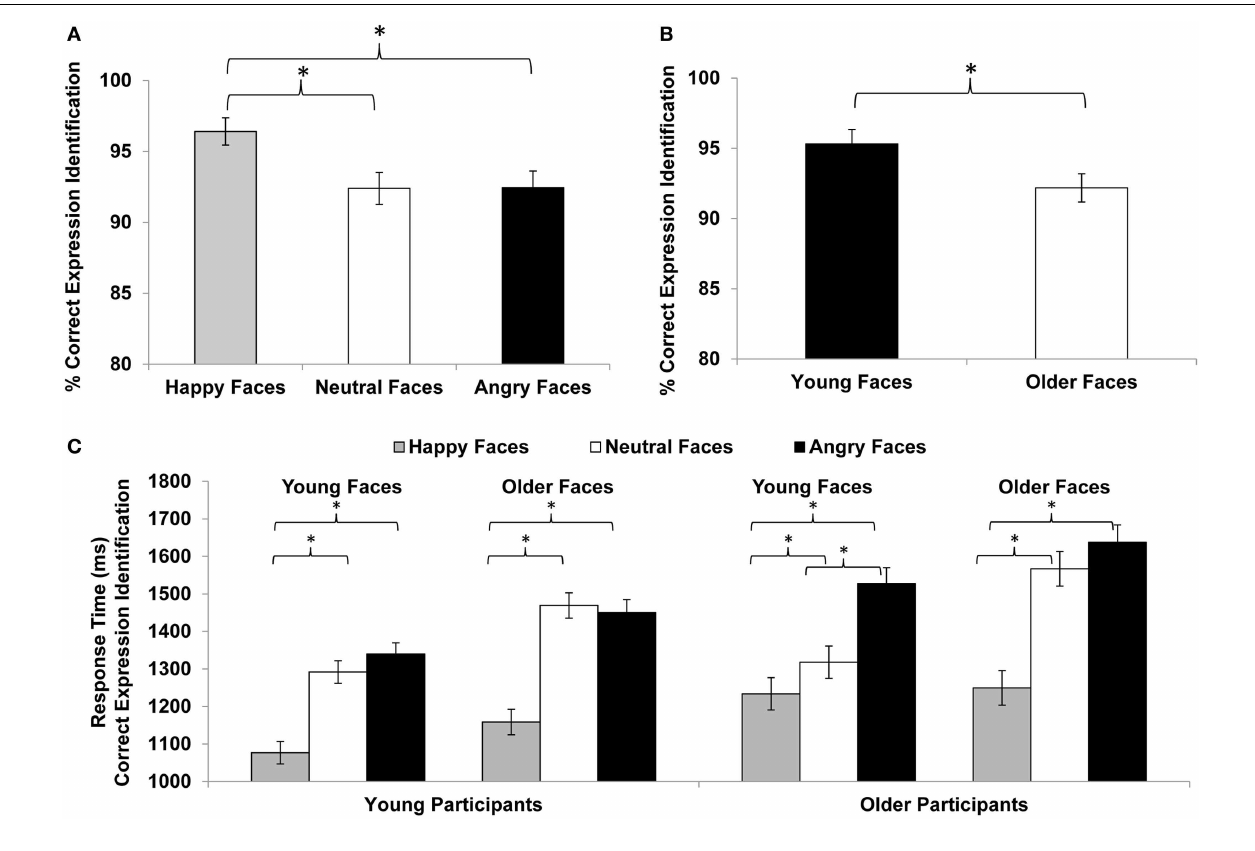
older participants for happy, neutral, and angry young and older faces. Error bars represent standard errors of condition mean differences; * p ≤